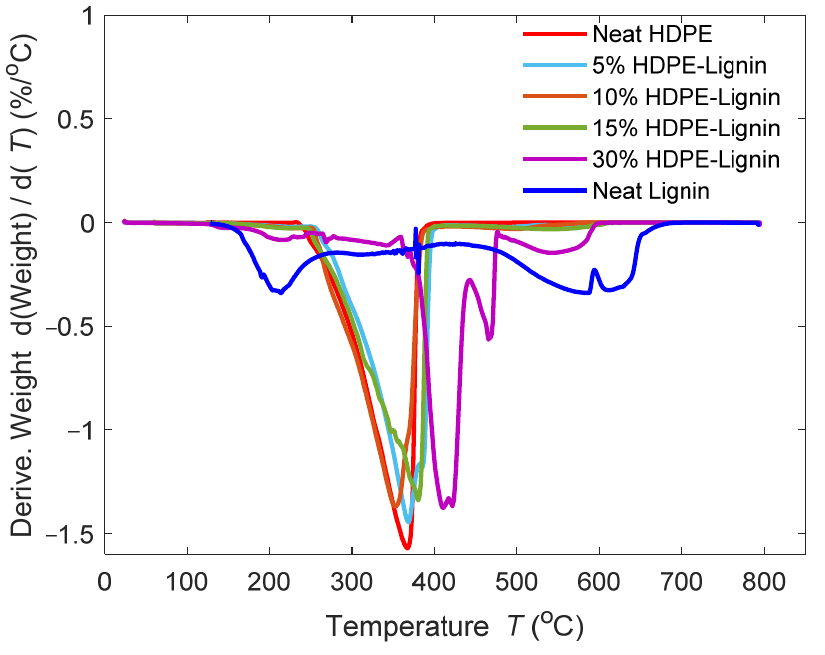
Figure 5. TGA curves for different blends of HDPE and lignin.